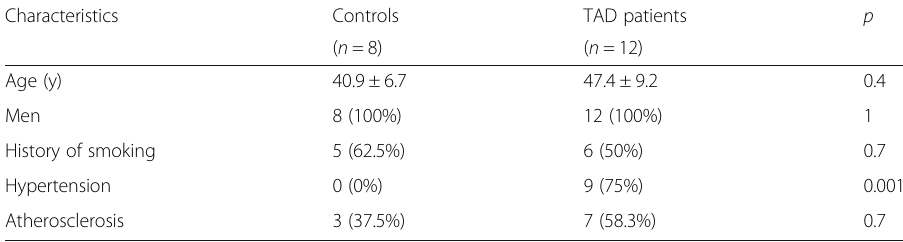
Table 1 Characteristics of the patients and controls